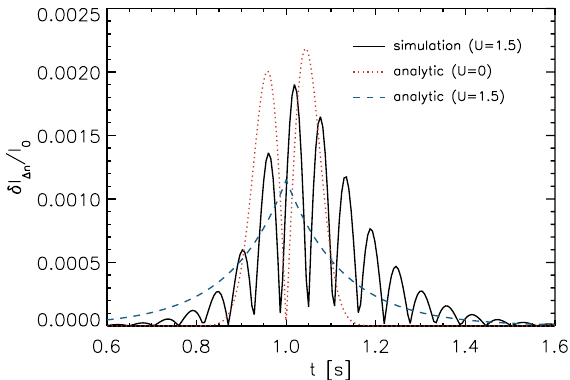
FIG. 5. (Color) Comparison of the echo amplitude versus time obtained from the simulation (solid line), the analytic ballistic echo theory (red dotted line), and from the analytic collective echo theory (blue dashed line) for U (cid:2) 0 : 5 and (cid:6) (cid:2) 0 : 1 s